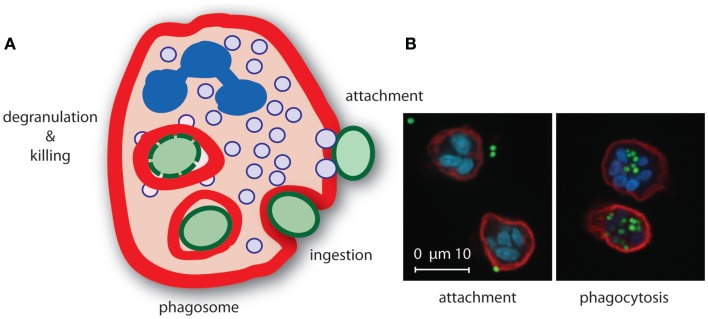
Neutrophil phagocytosis of S. aureus. (A) Upon recognition of opsonized S. aureus, neutrophils internalize the bacterium in a phagosome where secretory granule content is released and ROS are produced that mediate killing of the bacterium. (B) Confocal microscopy image of S. aureus expressing green fluorescence protein (green) attached (left) to and phagocytosed (right) by neutrophils [red, membrane stain wheat germ agglutinin (WGA)-Alexa647, blue, nucleic acid stain Syto82].